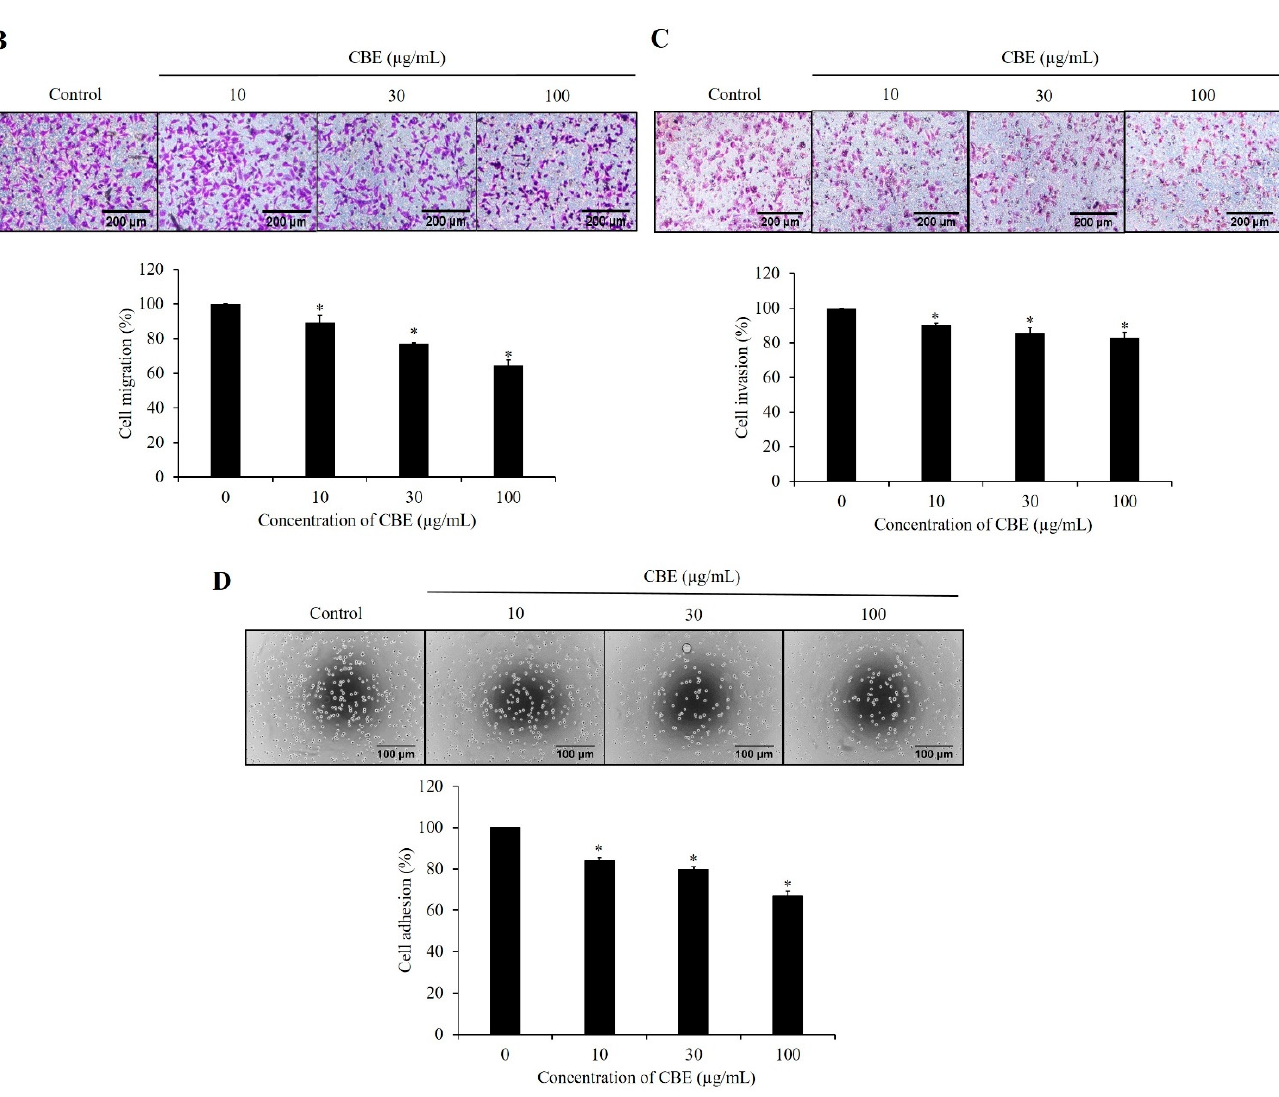
Figure 2. Effect of CBE on migration, invasion, and adhesion of LoVo cells. ( A ) LoVo cells were treated with or without CBE at 0, 24, and 48 h and detected by scratch assay and wound area was analyzed by Image J. ( B ) Transwell migration assay after treatment of CBE for 24 h. ( C ) Transwell invasion assay after treatment of CBE for 24 h. ( D ) The adhesive ability of CBE-treated LoVo cells were determined by Matrigel-adhesion assay. Results are presented as mean values ± SD ( n = 3). * p < 0.05 versus the control group. CBE, Cinnamomum bejolghota extract; SD, standard deviation.